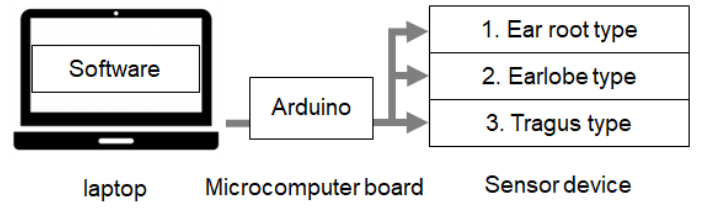
Figure 5. Prototype system configuration.